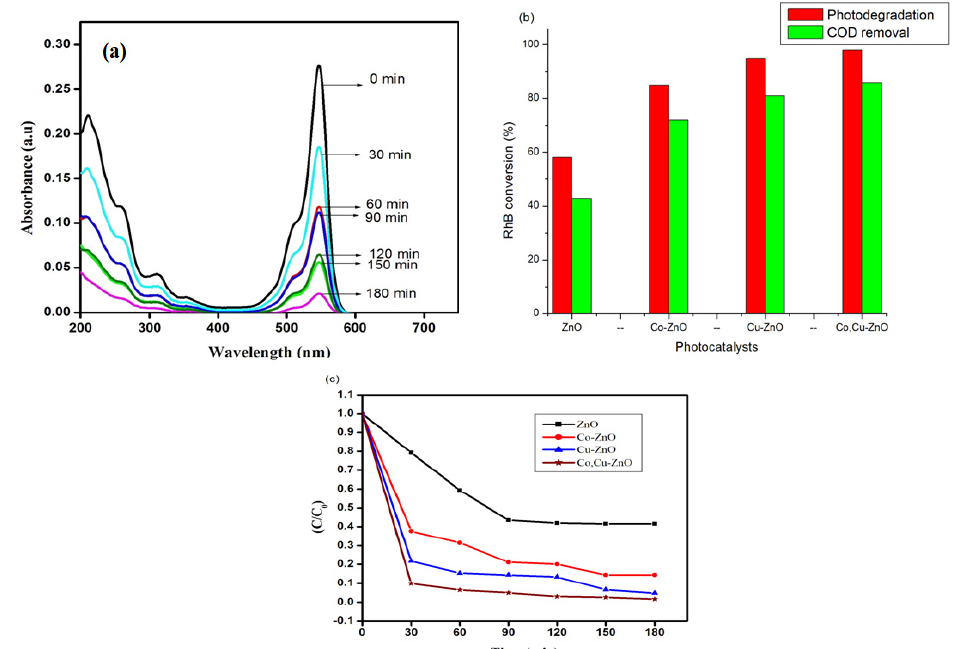
Fig. 8. (a) Time-dependent UV–vis spectral changes of RhB (5µM) in the presence of (Co, Cu)/ZnO (0.12 g/L) under visible light irradiation; (b) Comparison of photodegradation and COD removal percentage of RhB in the presence ZnO, Co–ZnO, Cu–ZnO and (Co, Cu)/ZnO and (c) Degradation of RhB as a function of irradiation time in the presence of ZnO, Co-ZnO, Cu-ZnO and Co, Cu codoped ZnO